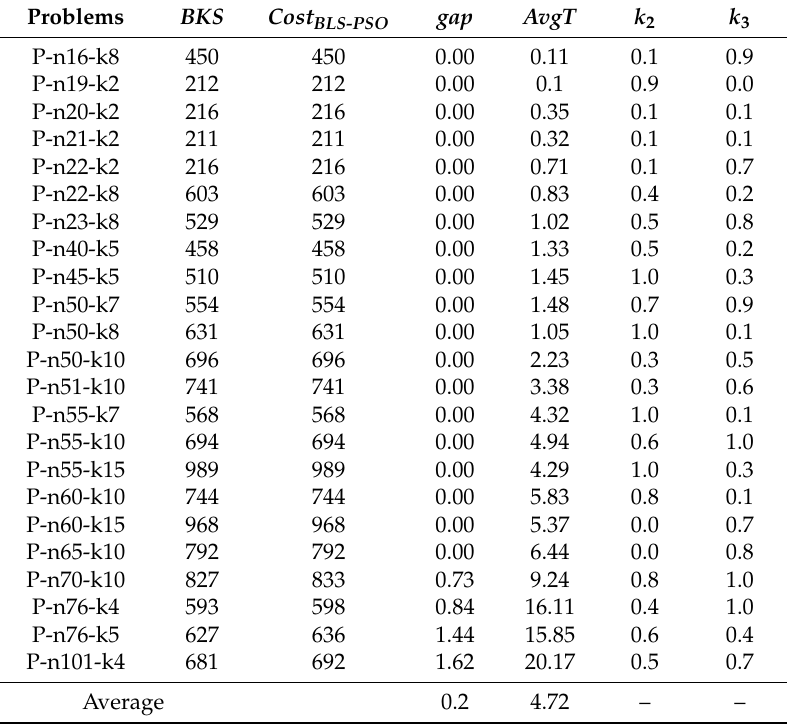
Table 9. Performance of BLS-PSO in solving the benchmark problems in Set P.